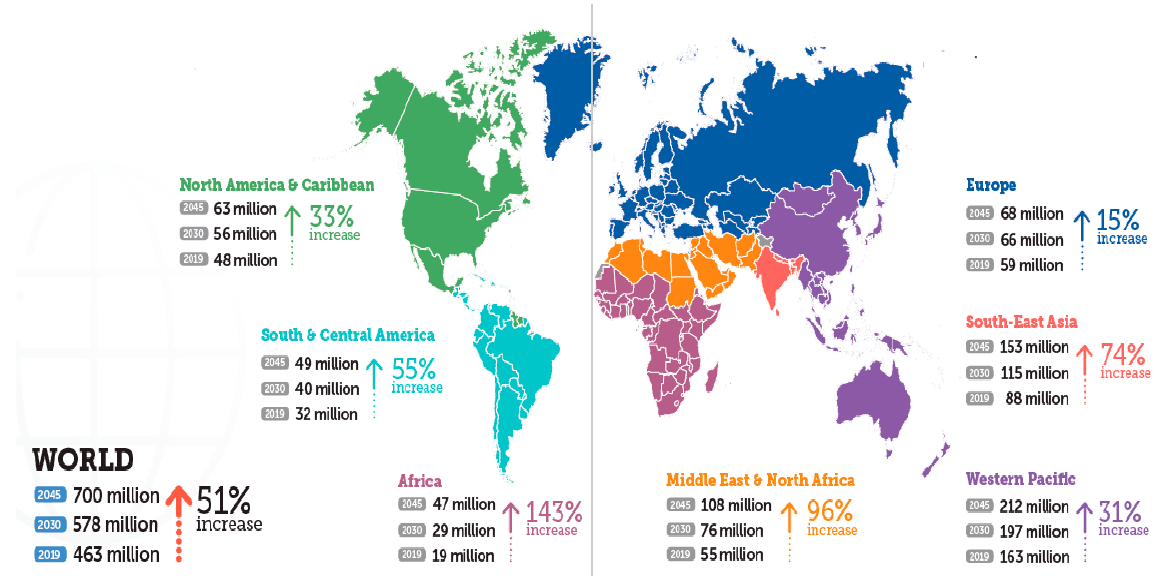
Figure 4. Number of people with diabetes worldwide and per IDF region in 2019, 2030 and 2045 (age 20–79 years). Source: IDF Diabetes Atlas editions [8].